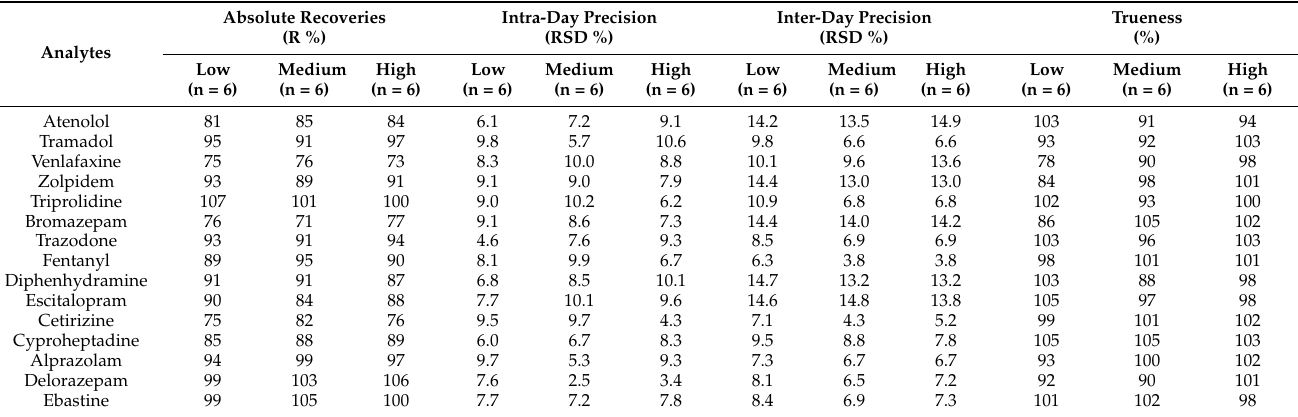
Table 2. Absolute recoveries, method precision (intra and inter-day precision) expressed as relative standard deviation (RSD) and method accuracy expressed as trueness. For each validation level a number of 6 (n = 6) replicates were